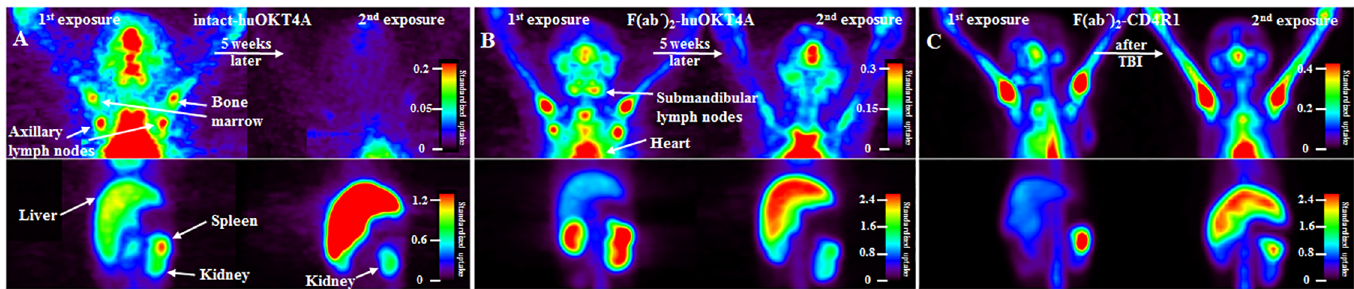
Fig 4. Maximum intensity projection SPECT images. Rhesus macaquesthat developed antibody responseto the radiotracer after baselineexposurewere subsequently imagedwhileanti-tracer antibodieswere present in the plasma in (A) healthy macaqueimagedat 48 hours post-radiotracer injectionwith intact- huOKT4A labelledwith 111 In and scannedusing Triad88 (Trionix) camera, (B) SIV-TK infected non-progressor imaged at 4 hours post-radiotracer injection with F(ab 0 ) 2 -huOKT4A labelledwith 99m Tc and scannedusing Triad88 (Trionix) camera, and (C) healthy macaquethat underwenttotal body irradiationprior to 2 nd exposure and imagedat 4 hours post-radiotracer injectionwith F(ab 0 ) 2 -CD4R1labelledwith 99m Tc and scannedusing Symbia T2 (Siemens) camera. Images show increasedhepatic uptake and altered biodistribution with minimalto no bindingobservedin secondary lymphoidorgans when imagedin the presenceof anti-tracer antibodies. Within each panel, images were adjusted(standardized) for injecteddose and body weight. Tissue uptakes were convertedto RAINBOW color scale as shown in color